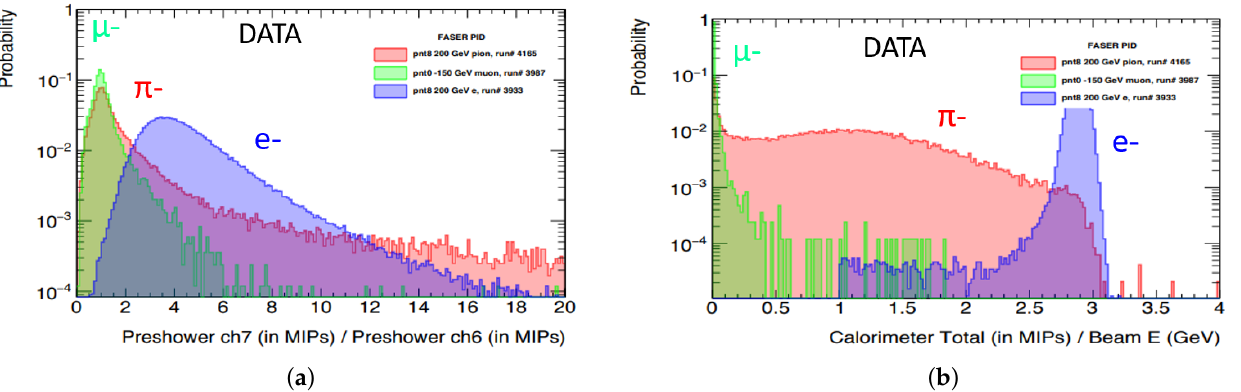
Figure 15. Test beam data PID plots showing 200 GeV pion (green), 150 GeV muon (red), and 200 GeV electron (blue) simulated signal. ( a ) The ratio of deposited energy (GeV) in the two pre-shower station scintillator layers. ( b ) The ratio of deposited energy in the calorimeter and beam energy (GeV).